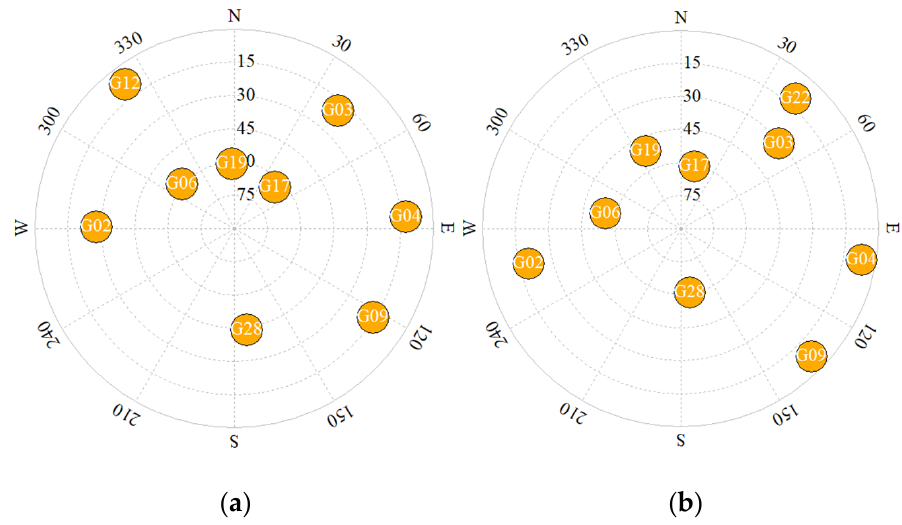
Figure 16. Satellite skyplots in dynamic scenario of Wuhan. ( a ) Clockwise. ( b ) Counter-clockwise.